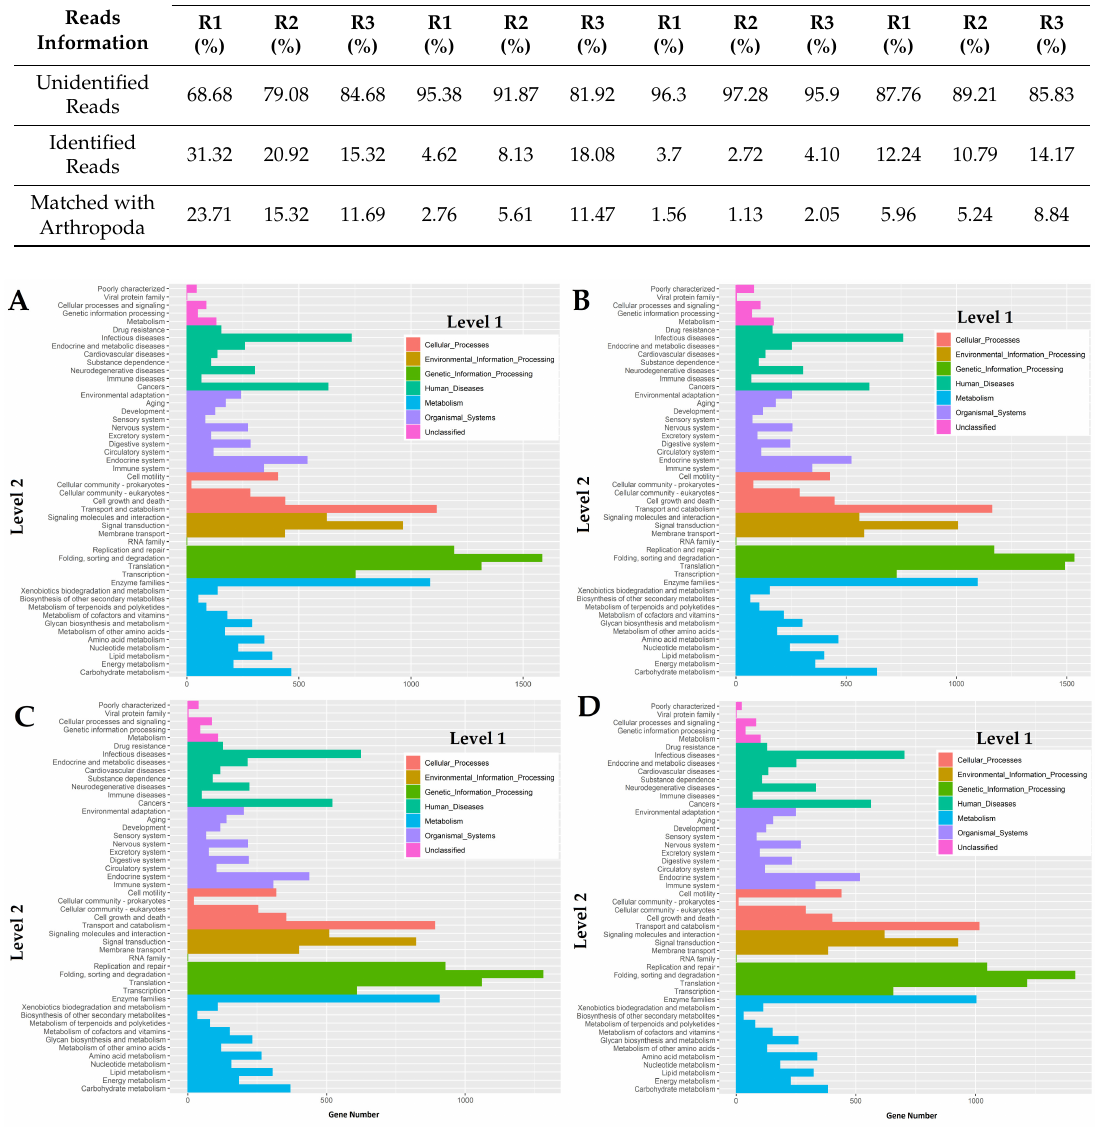
Figure 3. GO mapping of the cDNA libraries of ( A ) female mid-gut, ( B ) male mid-gut, ( C ) testes, and ( D ) ovaries of two-spotted field crickets by the Kyoto Encyclopedia of Genes and Genomes, KEGG